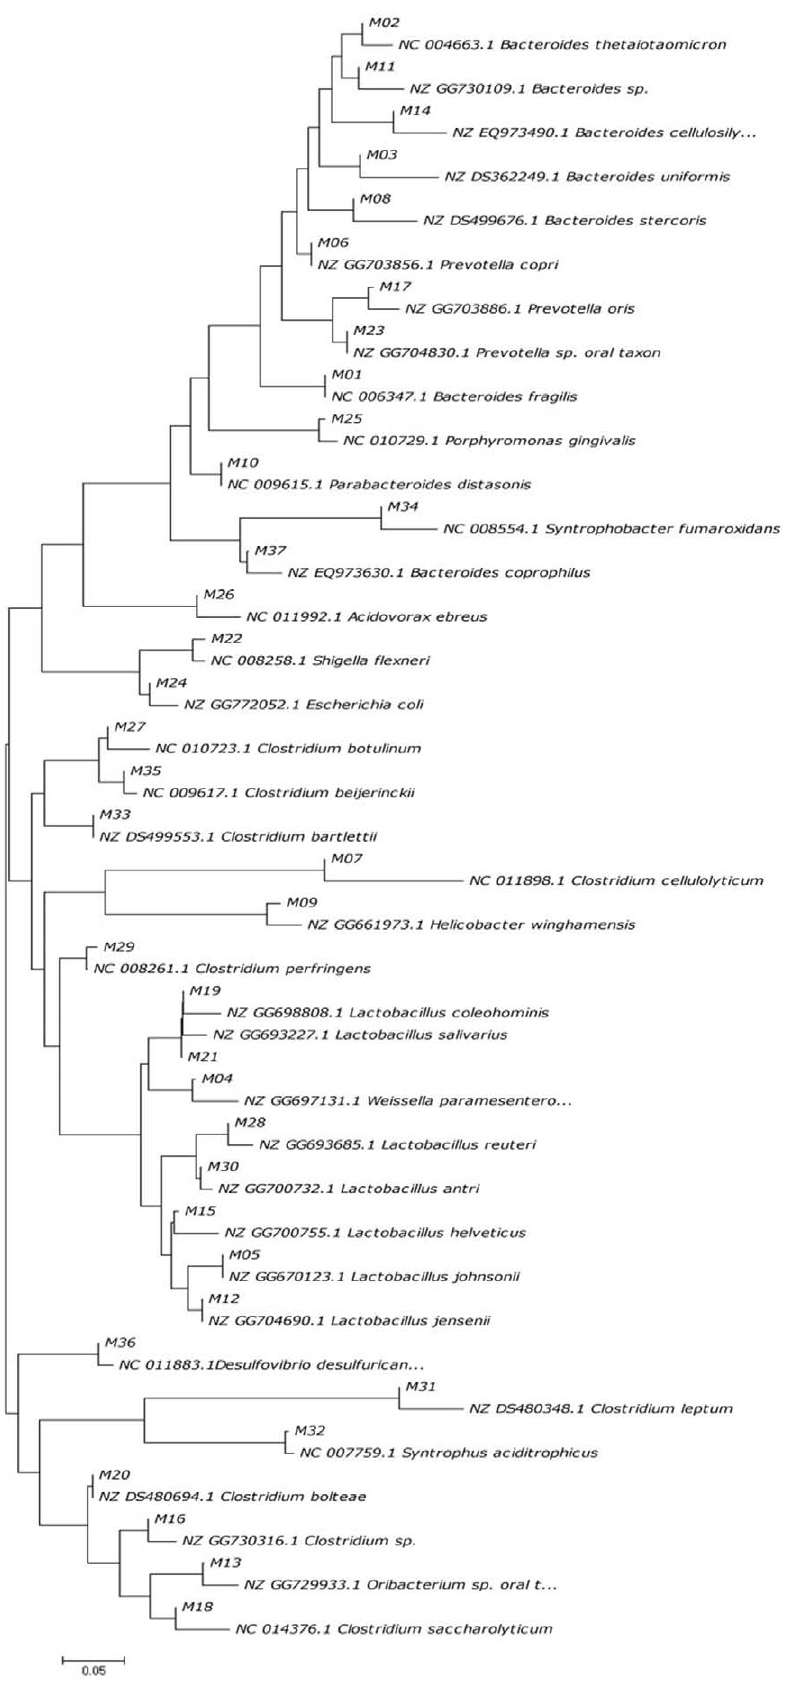
Figure 6. Phylogenetic tree for partial sequences of cloned 16S rDNA fragments and the most closely related bacteria. The tree was constructed by neighbor-joining analysis.